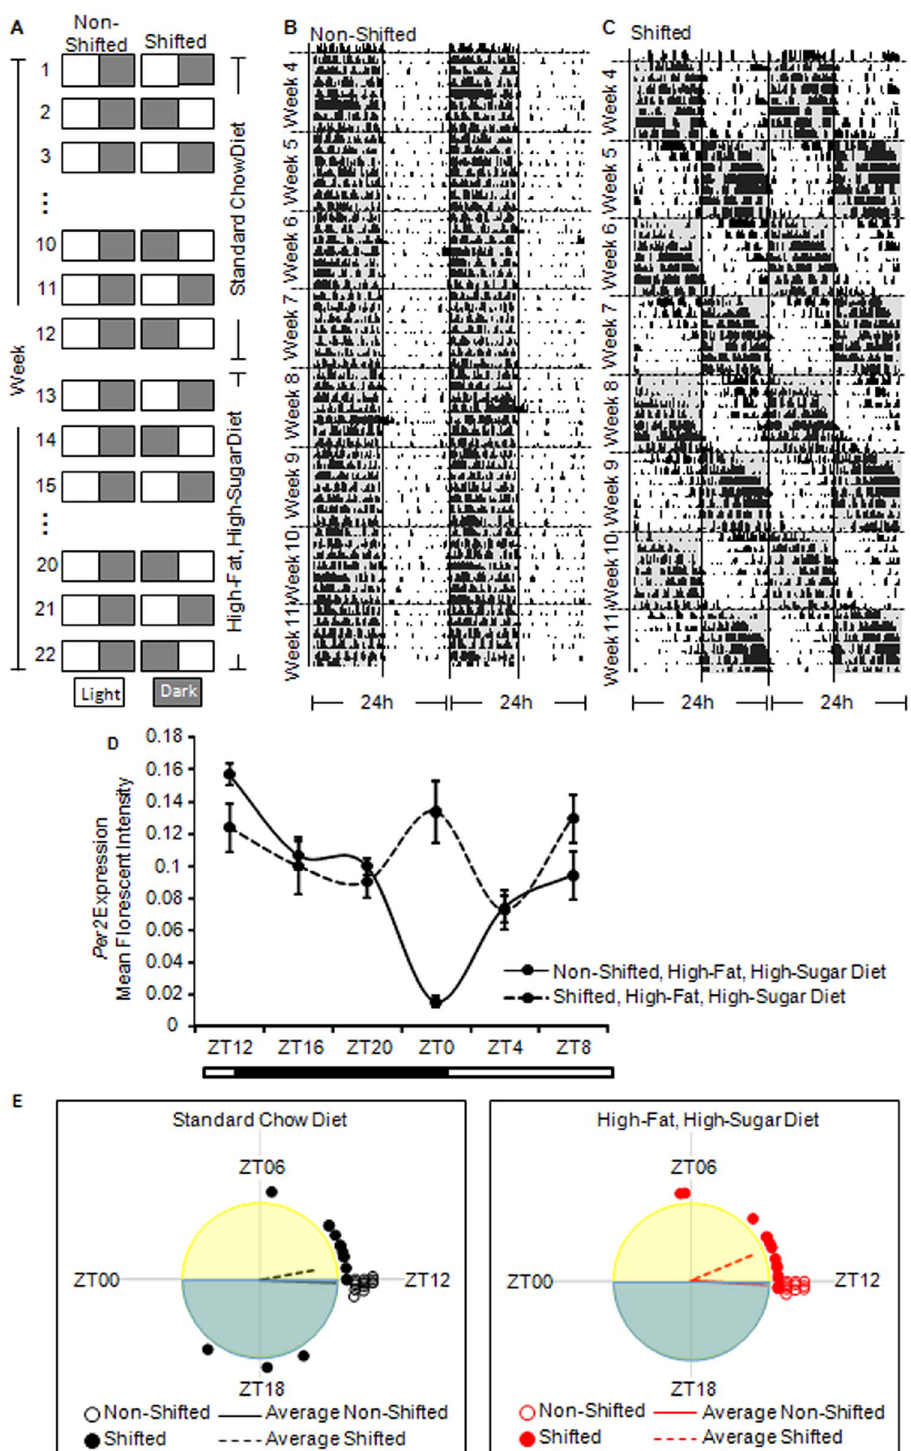
Figure 1. Protocol and timeline for circadian disruption, dietary changes, and stool collection. A. Non-shifted mice were kept on a constant light:dark schedule for the entirety of the experiment whereas Shifted mice underwent once weekly light:dark inversion. Mice were maintained on a standard chow diet for the first 12 weeks of the study followed by a stool collection at the end of week 12. Mice were subsequently placed on a high-fat, high-sugar diet for 10 weeks and stool was collected at the end Week 22. Representative behavioral activity recording for a Non- shifted (B) and Shifted mouse (C). Activity is represented as dark areas in the actogram. These data demonstrate that non-shifted mice have stable behavioral patterns while the shifted mice have disrupted behavioral patterns. D. Expression of Per2 mRNA in the proximal colon one day after the week 22 stool collection demonstrates altered circadian expression in the intestine following the 22 weeks of phase shifting. Significant effect of light condition, (F (1,58) =5.84, p=0.02), Zeitgeber Time (ZT) (F (5,58) =8.38, p , 0.0001), and light condition x ZT interaction (F (5,58) =9.67, p= , 0.0001). E.